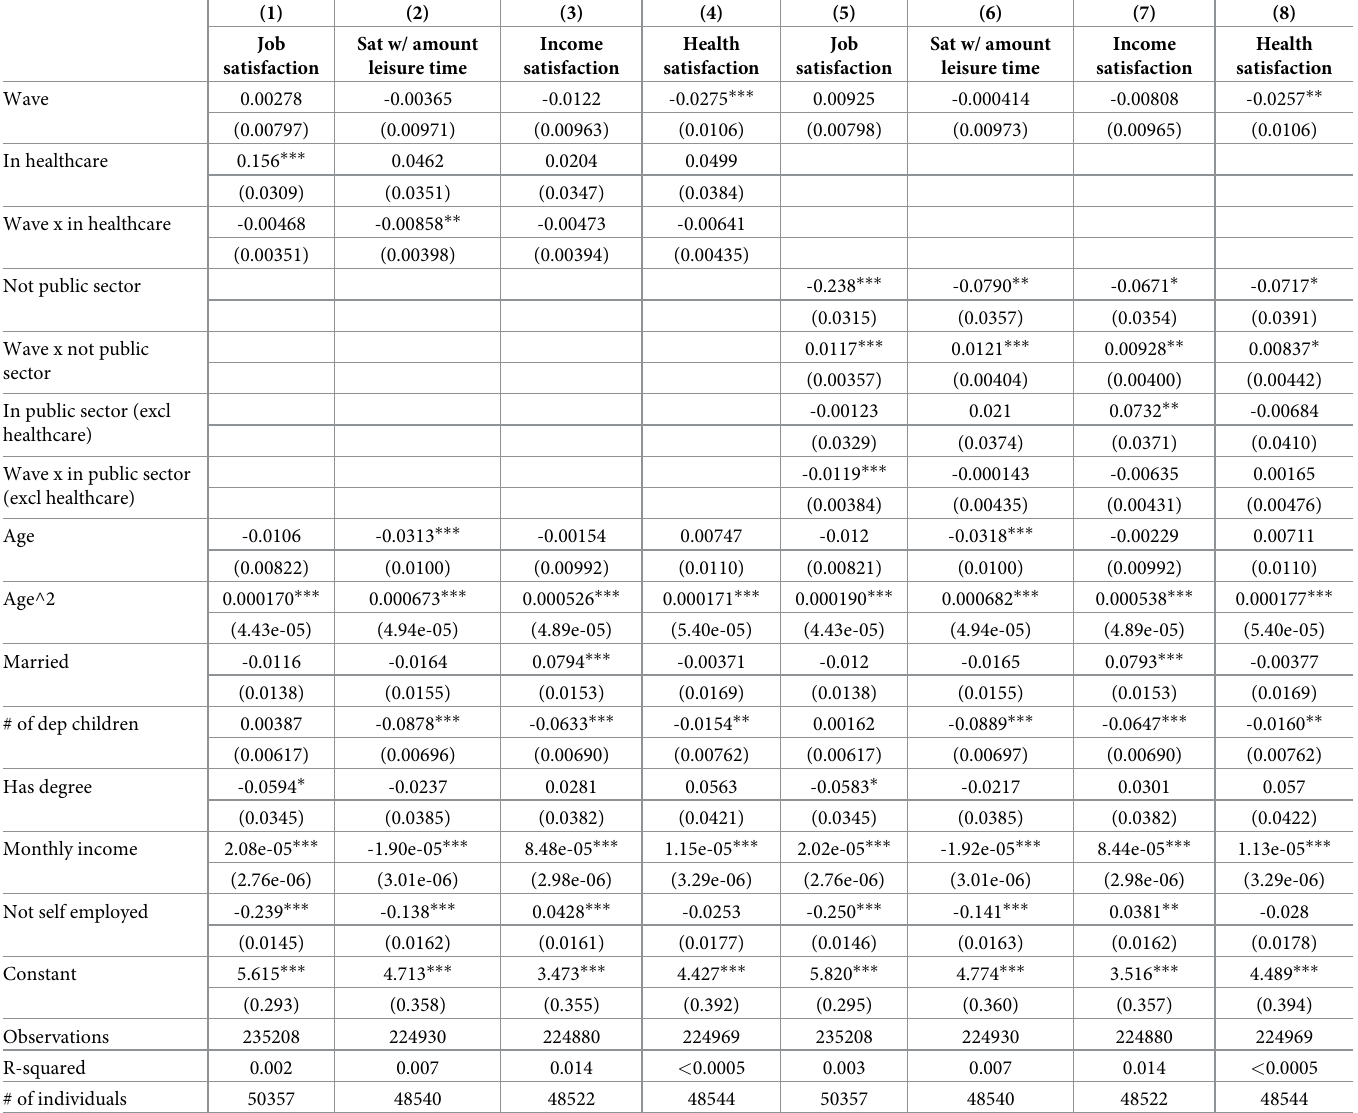
Table 1. Fixed-effects OLS regressions showing satisfaction over time for healthcare workers, relative to workers outside